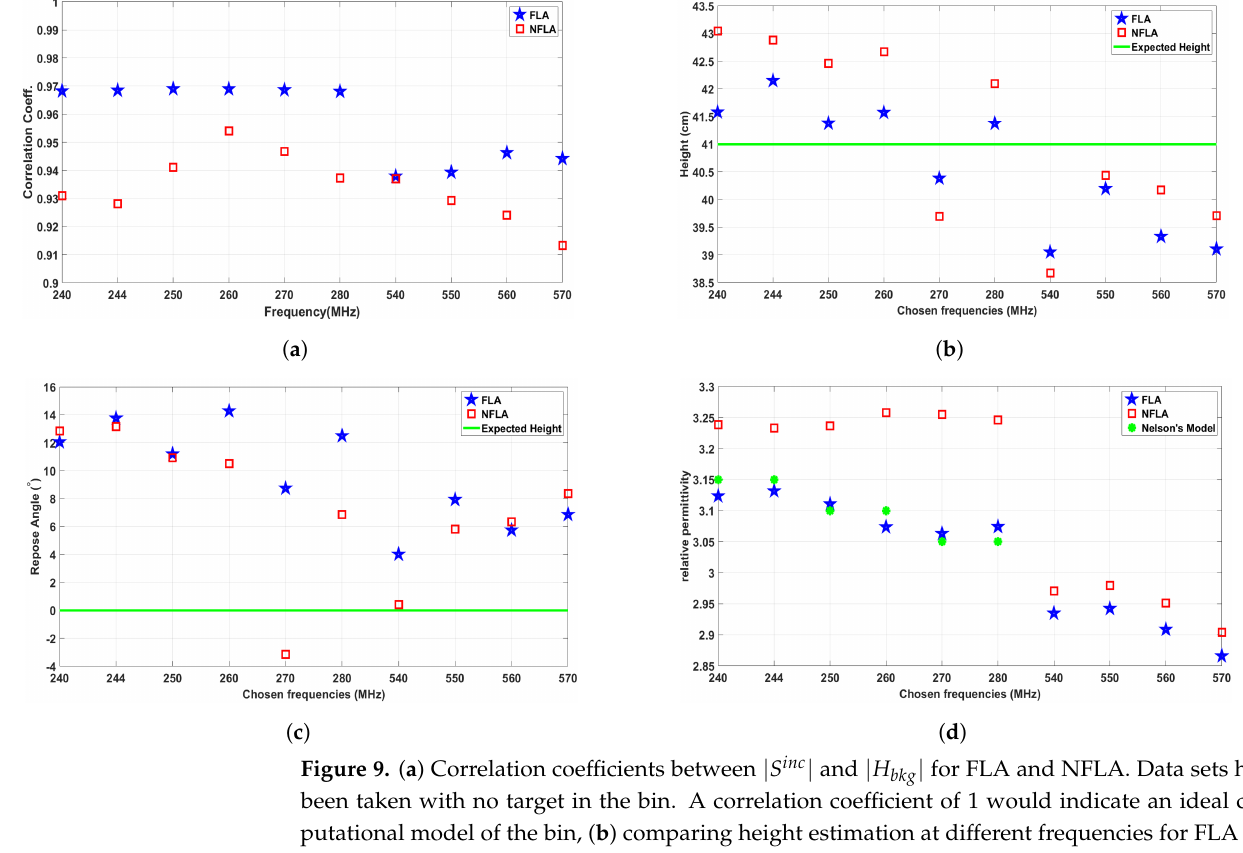
Figure 9. ( a ) Correlation coefficients between | S inc | and | H bkg | for FLA and NFLA. Data sets have been taken with no target in the bin. A correlation coefficient of 1 would indicate an ideal com- putational model of the bin, ( b ) comparing height estimation at different frequencies for FLA and NFLA, ( c ) Comparing position angle estimation at different frequencies for FLA and NFLA, and ( d ) Comparing relative permittivity ( (cid:101) r ) estimation at different frequencies for FLA and NFLA. Note that the x -axis (frequency) division is not